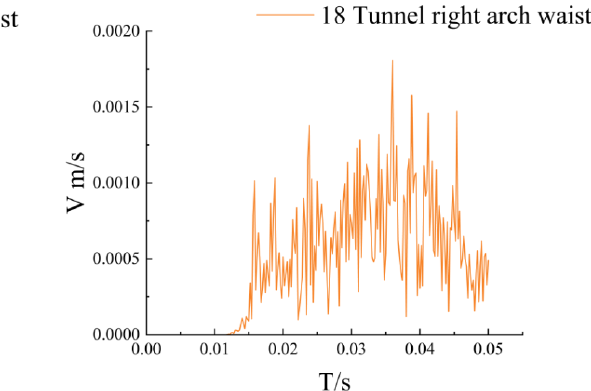
Figure 5. Vibrational velocity curve of the right arch shoulder of the plain concrete tunnel.